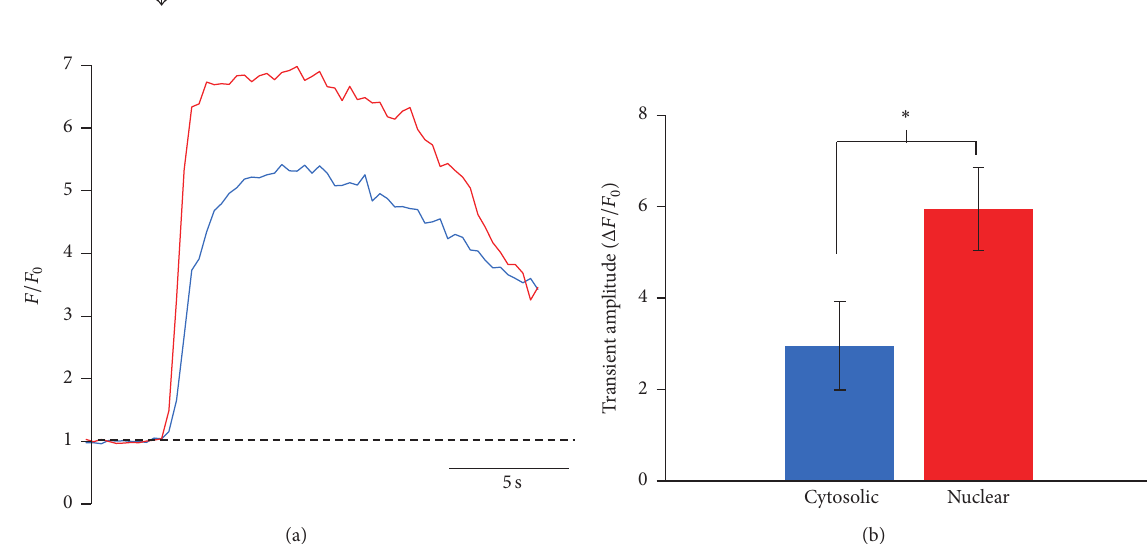
Figure 2: Nuclear Ca 2+ increases more than cytosolic Ca 2+ in response to electrical stimulation. Fluo-4/AM-loaded hcCPCs were stimulated at 0.5 Hz and the amplitudes of the nuclear and cytosolic Ca 2+ oscillations were analyzed. Representative traces of nuclear (red) and cytosolic (blue) Ca 2+ oscillations are shown in (a), and amplitudes are summarized in (b). Data represent mean ± SD. ∗ 𝑝 < 0.05 ; Student’s 𝑡 -test. 𝑛 = 16 cells from 4 different pools of cells for all